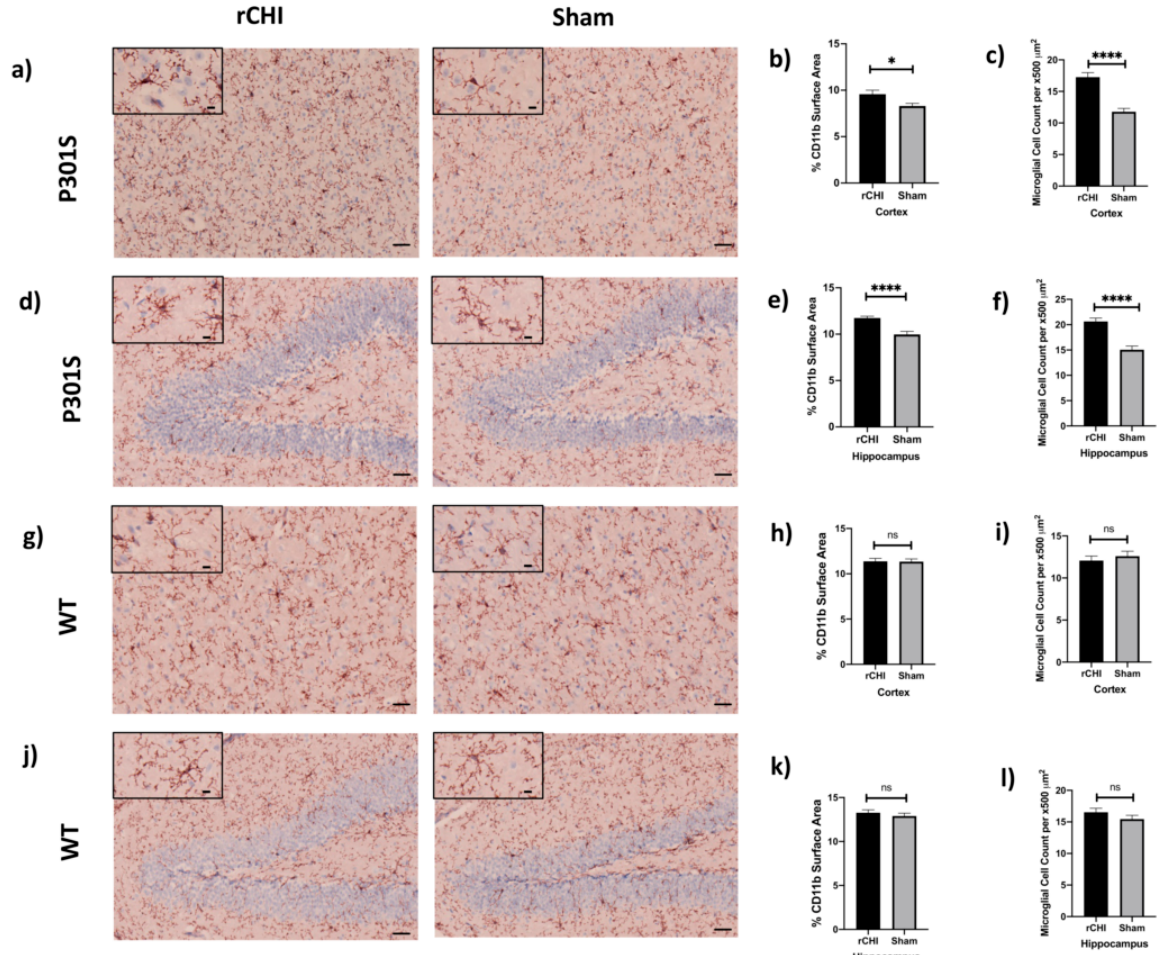
Figure 2. Repetitive closed-head injury (rCHI) induced microgliosis in adolescent P301S but not WT mice at 40 days post-injury. Representative IHC of CD11b of ( a ) cortex and ( d ) hippocampus of rCHI and sham P301S mice at 40 days post-injury. Bar graphs show increase in percent area of CD11b staining in ( b ) cortex and ( e ) hippocampus in rCHI vs. sham P301S mice ( n = 4/group, p = 0.02, p < 0.0001, respectively). Representative IHC of CD11b of ( g ) cortex and ( j ) hippocampus of rCHI and sham WT mice at 40 days post-injury. Bar graphs show no significant difference in percent area of CD11b between rCHI and sham WT animals in both ( h ) cortex and ( k ) hippocampus ( n = 4/group, p = 0.92, p = 0.42, respectively). Manual quantification of CD11b positive cells shows significant increase in CC11b in ( c ) the cortex and ( f ) the hippocampus of rCHI compared to sham P301S mice ( n = 3/group, p < 0.0001, p < 0.0001, respectively). Manual quantification of CD11b positive cells in ( i ) cortex and ( l ) hippocampus of rCHI and sham WT mice showed no significant differences between the groups ( n = 4/group, p = 0.51, p = 0.21, respectively). Statistical significance is denoted as follows: ns (non-significant) p > 0.05, * p 0.05, **** p 0.0001. Scale bars are 50 μ m, and 10 μ m for photomicrographs on increasing magnification.